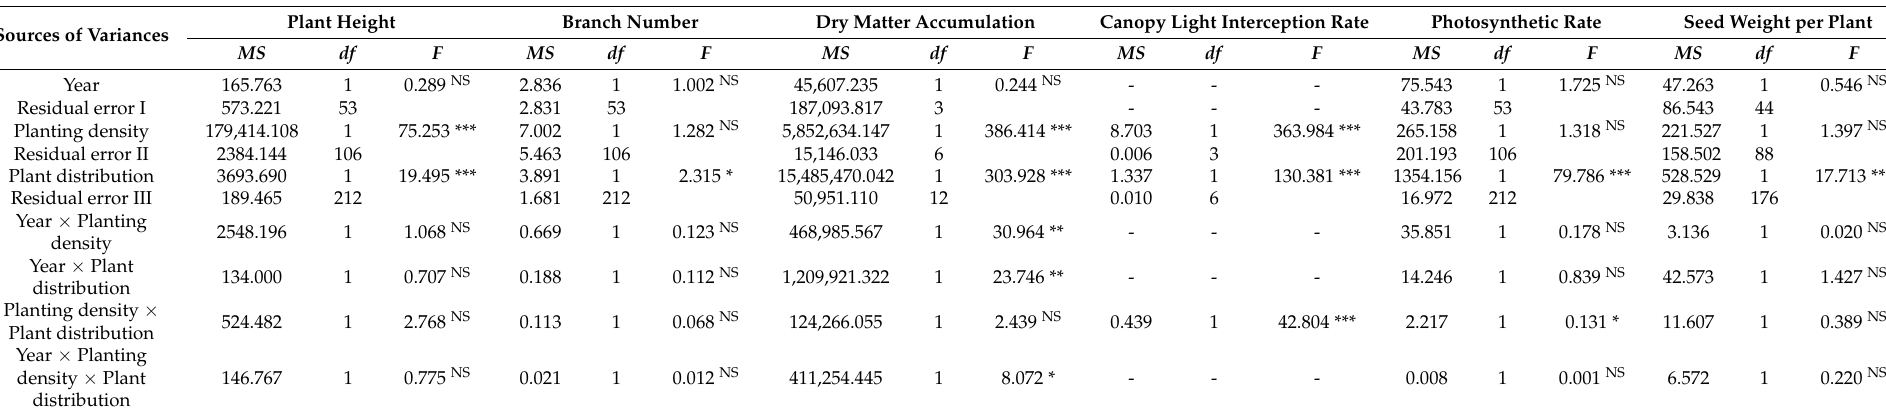
Table 2. The ANOVA of plant height, branch number, dry matter accumulation, canopy light interception rate, photosynthetic rate, and seed weight per plant for soybean under different planting